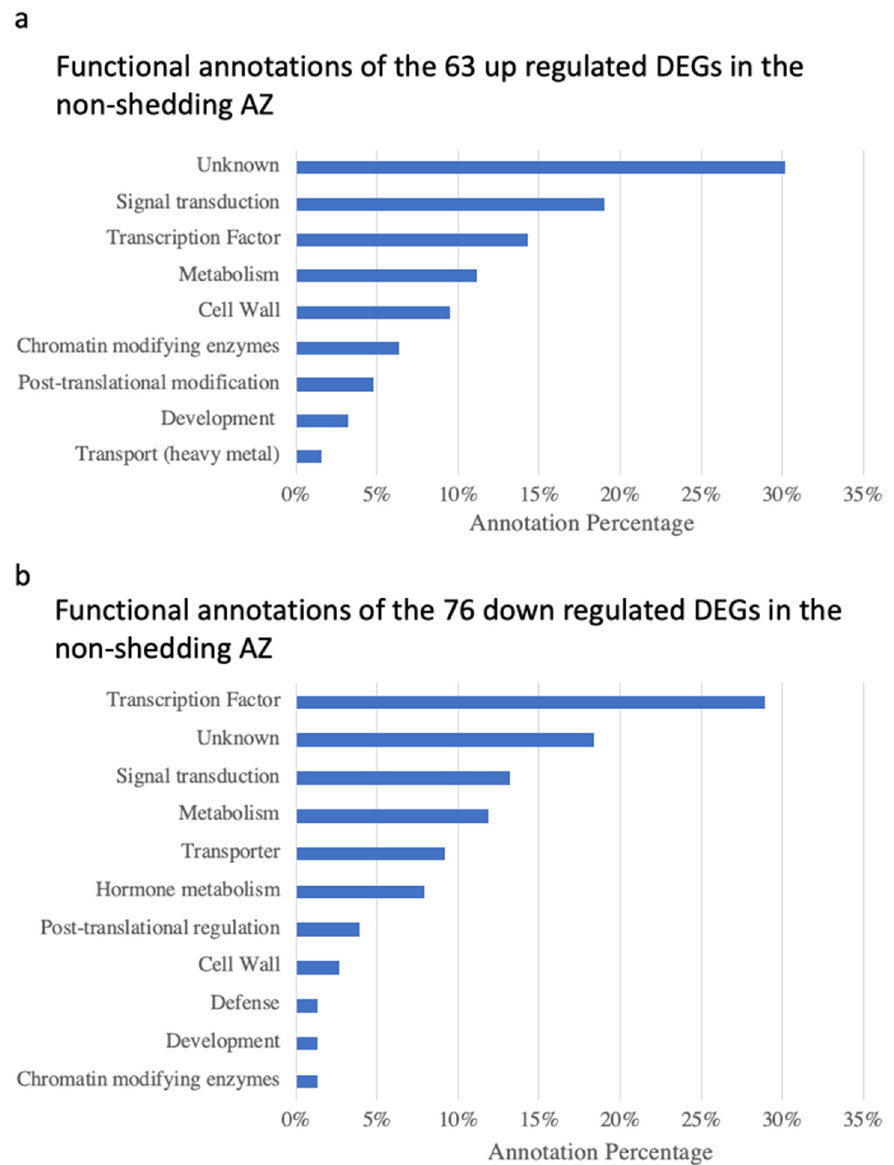
Figure 4. Functional annotations of the up- ( a ) and downregulated ( b ) DEGs revealed in the NSd fruit palm AZ compared with the Sd fruit